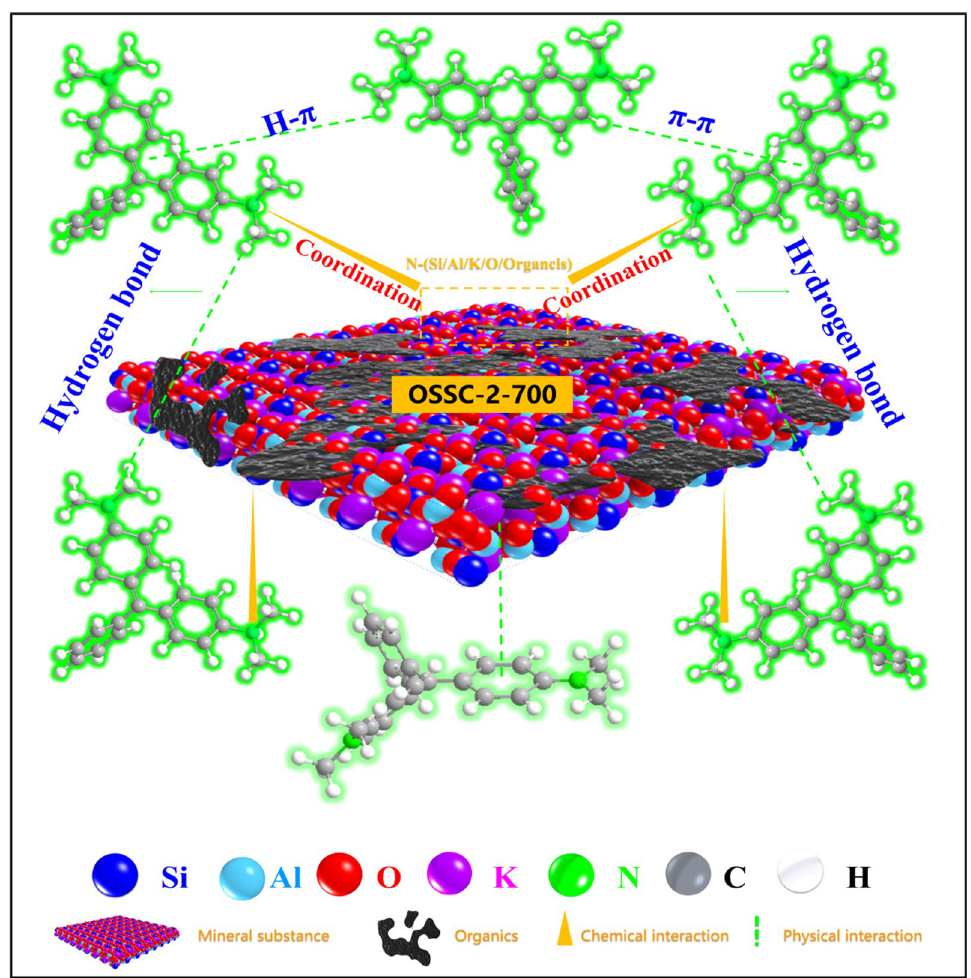
Fig. 8 Schematic diagram of the possible adsorption mechanisms of OSSC-2-700 toward organic contaminants using MG as an